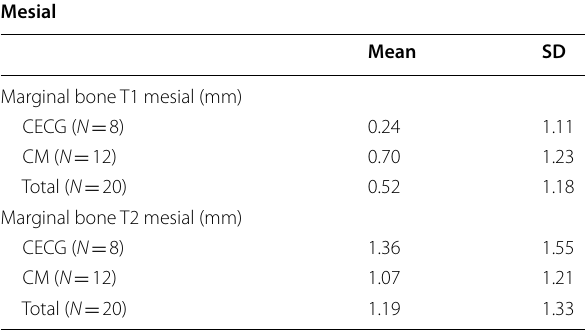
= 0.0161 between timepoints T1 and T2 ( p Wilcox ). No significant difference was found in the CECG group = 0.7422 (: p Wilcox ).